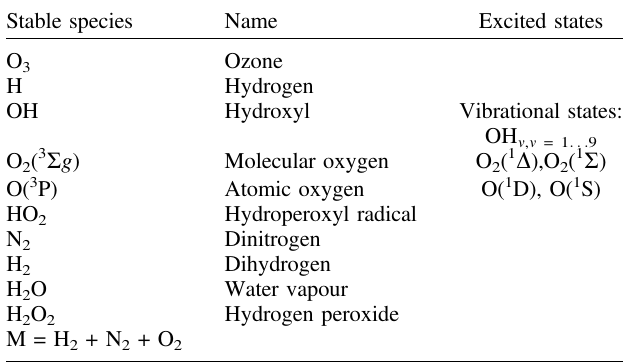
Table 1. List of the species used in the present model. Excited states are used for OH (all vibrational, from 1 to 9), and also O 2 ( 1 D ), O 2 ( 1 R ), O( 1 D), and O( 1 S). Stable species Name Excited states